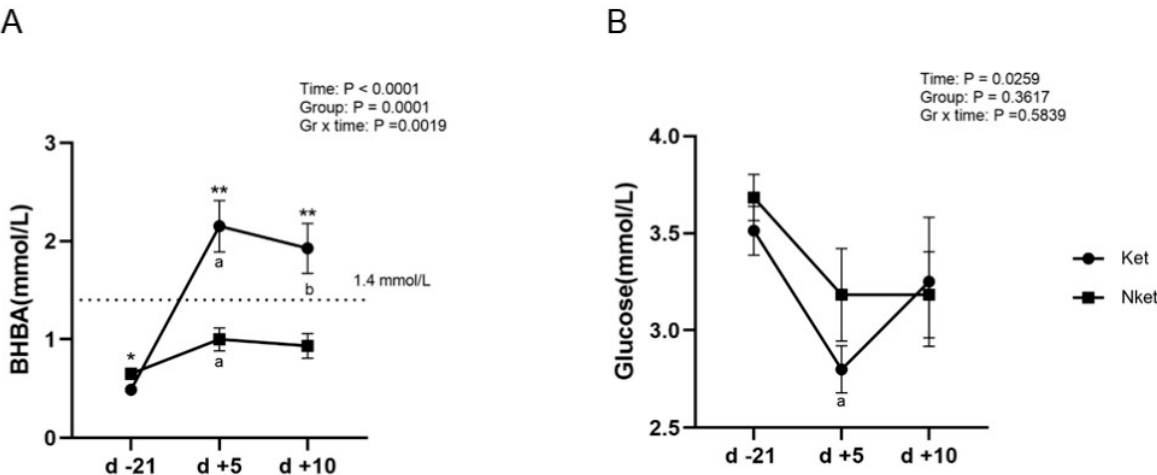
Figure 1. Changes in blood BHBA and glucose. Blood BHBA. ( A ) Glucose; ( B ) in ketotic cows (Ket, n = 8) and non-ketotic cows (Nket, n = 6) on d − 21, d +5, and d +10 relative to parturition (LSM ± SEM). * and ** indicate p < 0.05 and p < 0.01 between the two groups at the same time point, respectively. Compared to d − 21, a and b indicate p < 0.05 for d +5 and d +10 post − partum, respectively.